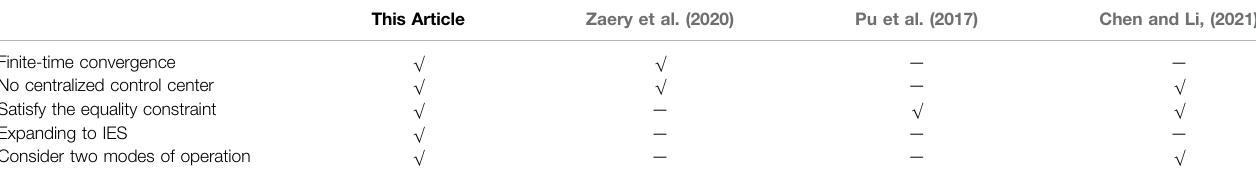
TABLE 2 | Comparison of algorithms proposed in related literature.